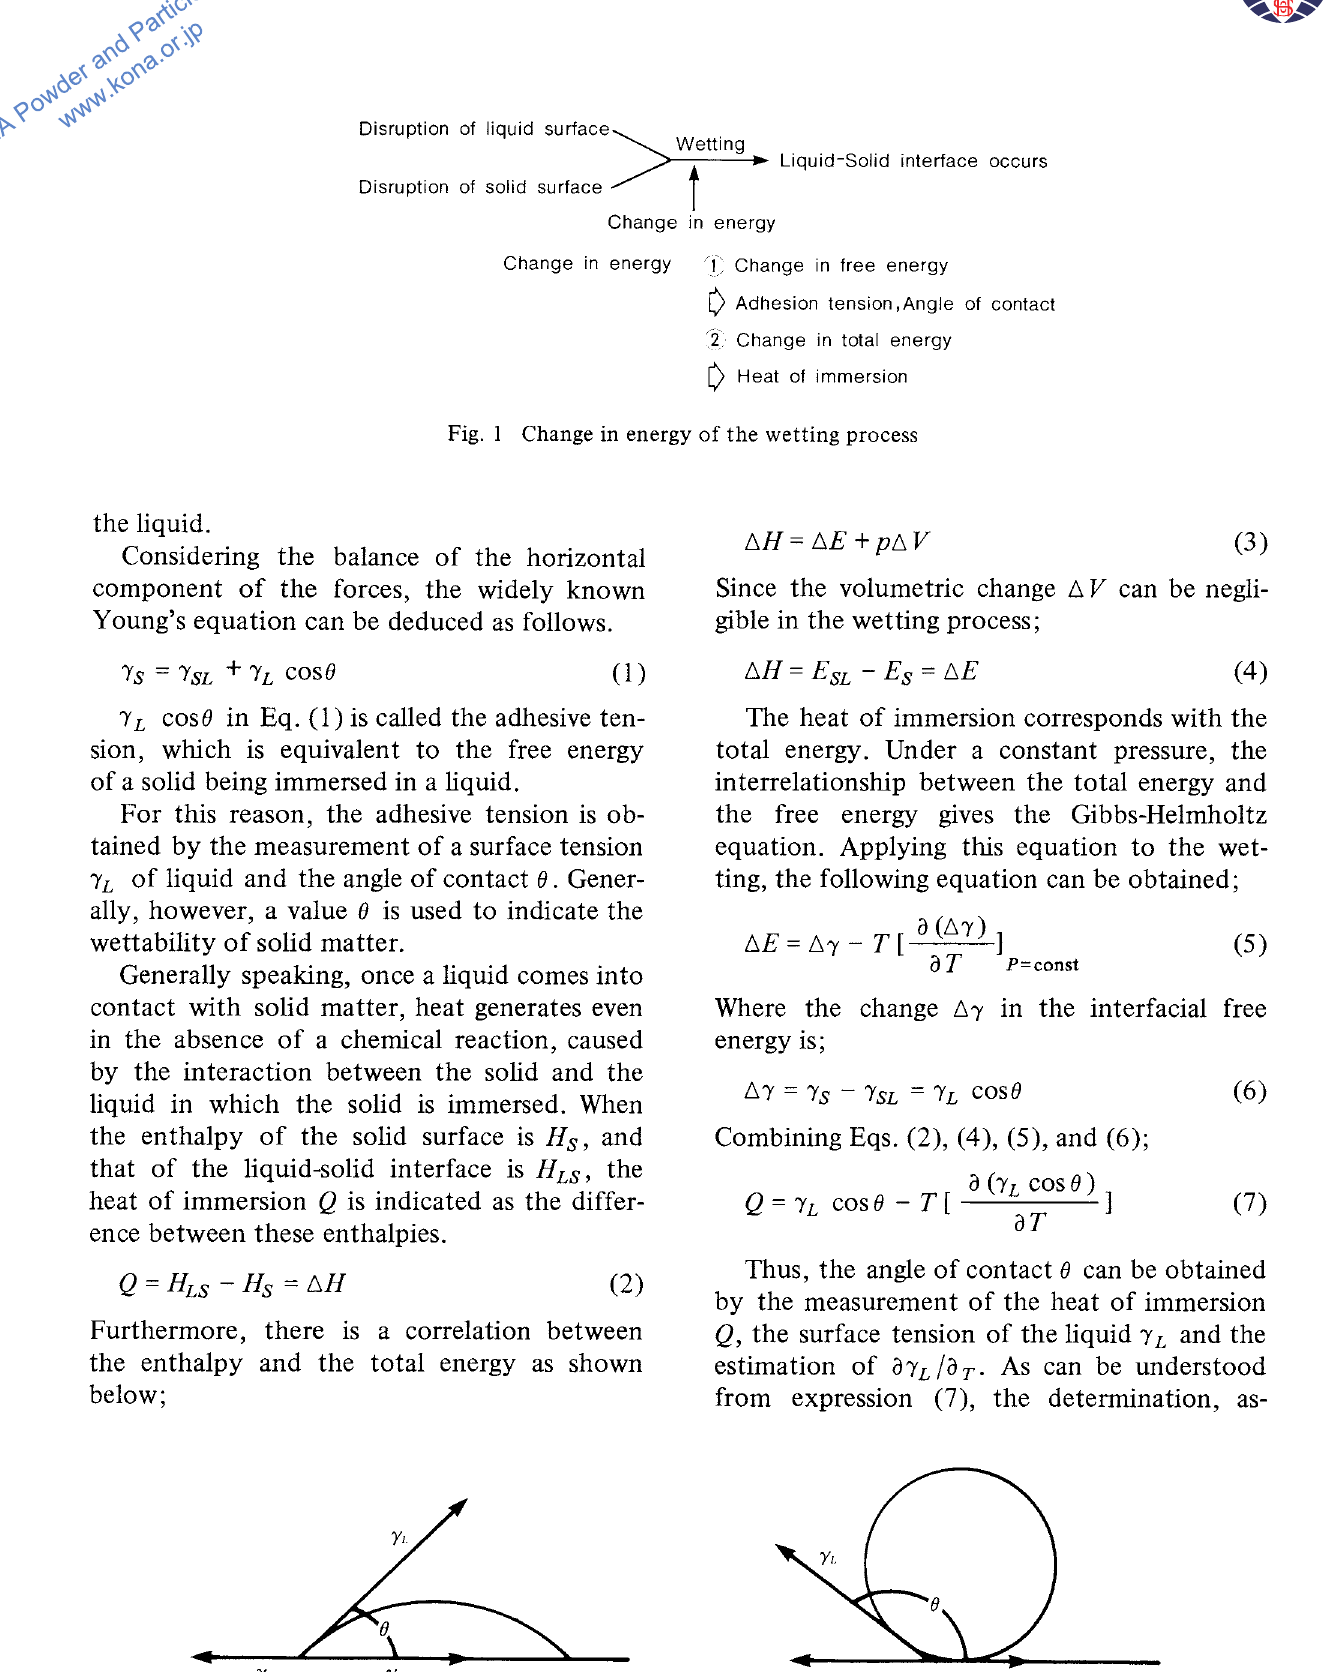
Fig. 2 Wetting with liquid on a solid